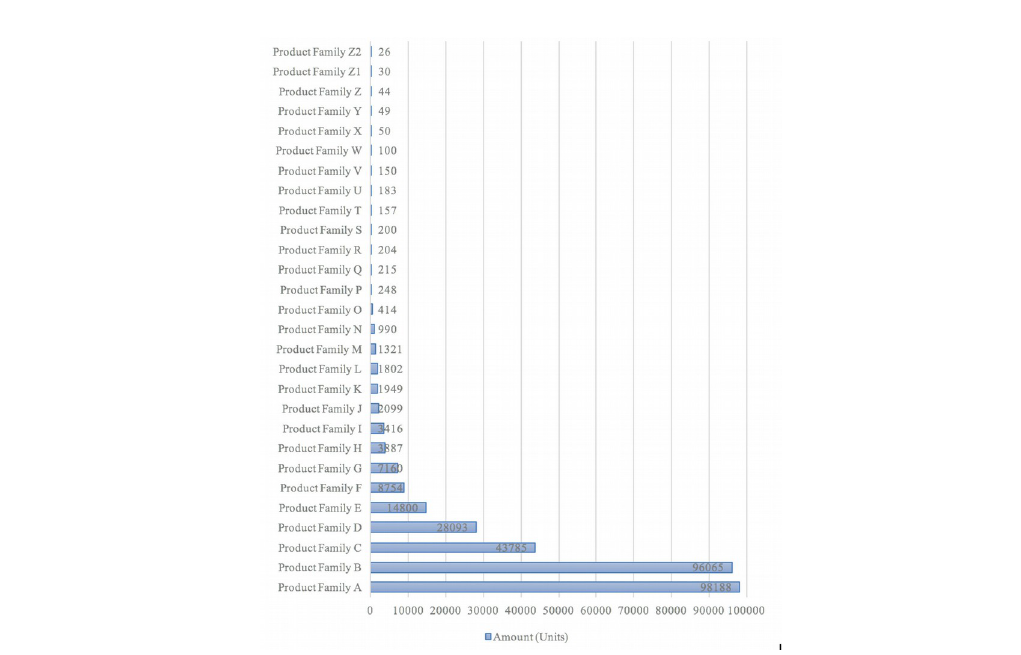
Figure 4. Product family selection